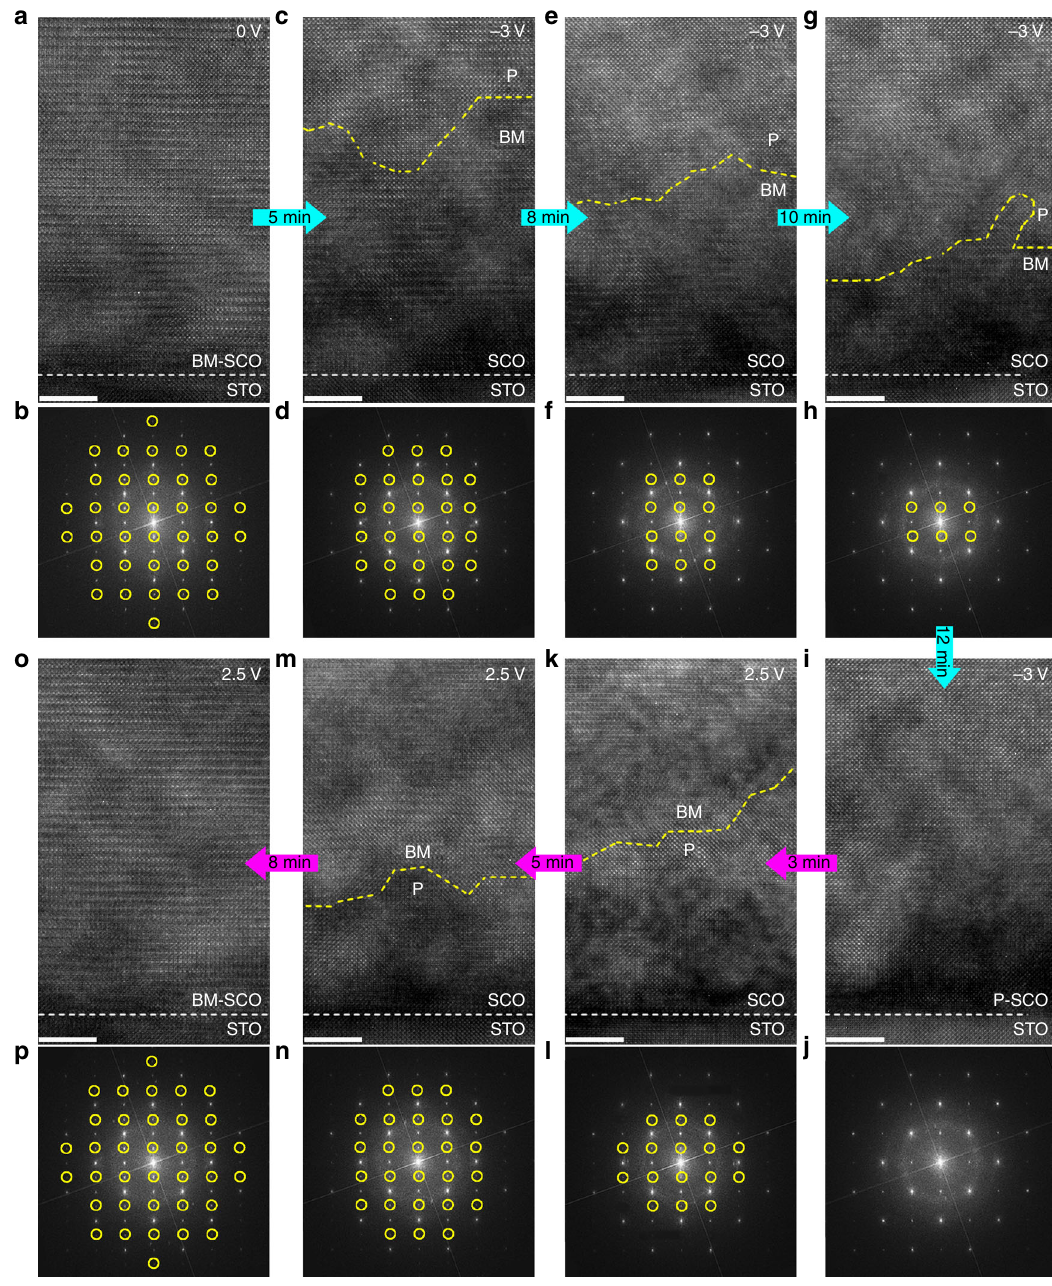
Fig. 2 In situ TEM results of SrCoO x under ionic liquid gating. TEM images and corresponding FFT diffractograms for SrCoO x (SCO)/(001) SrTiO 3 (STO) after the application of various gate voltages and gating times: a , b V G = 0 V, 0 min; c , d V G = – 3 V, 5 min; e , f V G = – 3 V, 8 min; g , h V G = – 3 V, 10 min; i , j V G = – 3 V, 12 min; k , l V G = + 2.5 V, 3 min; m , n V G = + 2.5 V, 5 min; o , p V G = + 2.5 V, 8 min. The white scale bars in TEM images are 5 nm. The yellow and white dashed lines in the TEM images indicate the boundary between brownmillerite (BM) and the perovskite (P) SCO phases, and the interface between SCO and STO, respectively. The yellow circles in the FFTs denote the superlattice re fl ections resulting from the modulated structure in the brownmillerite phase. The cyan and magenta arrows indicate the sequence of images taken. Cyan corresponds to V G = – 3 V and magenta to V G = + 2.5